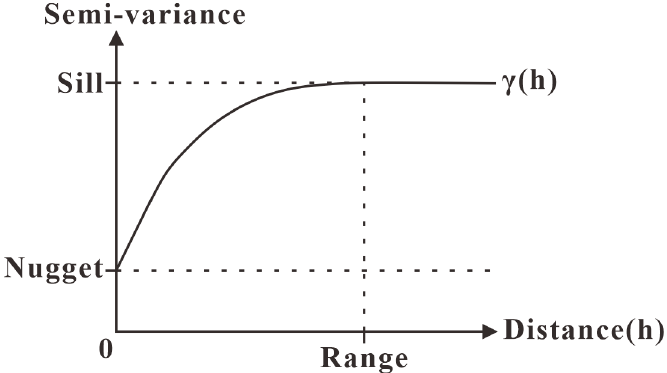
Figure 2 . Schematic diagram of variation function (edited from [5,50–52]). Figure 2. Schematic diagram of variation function (edited from [5,50–52]). The range refers to the range where regionalized variables have spatial